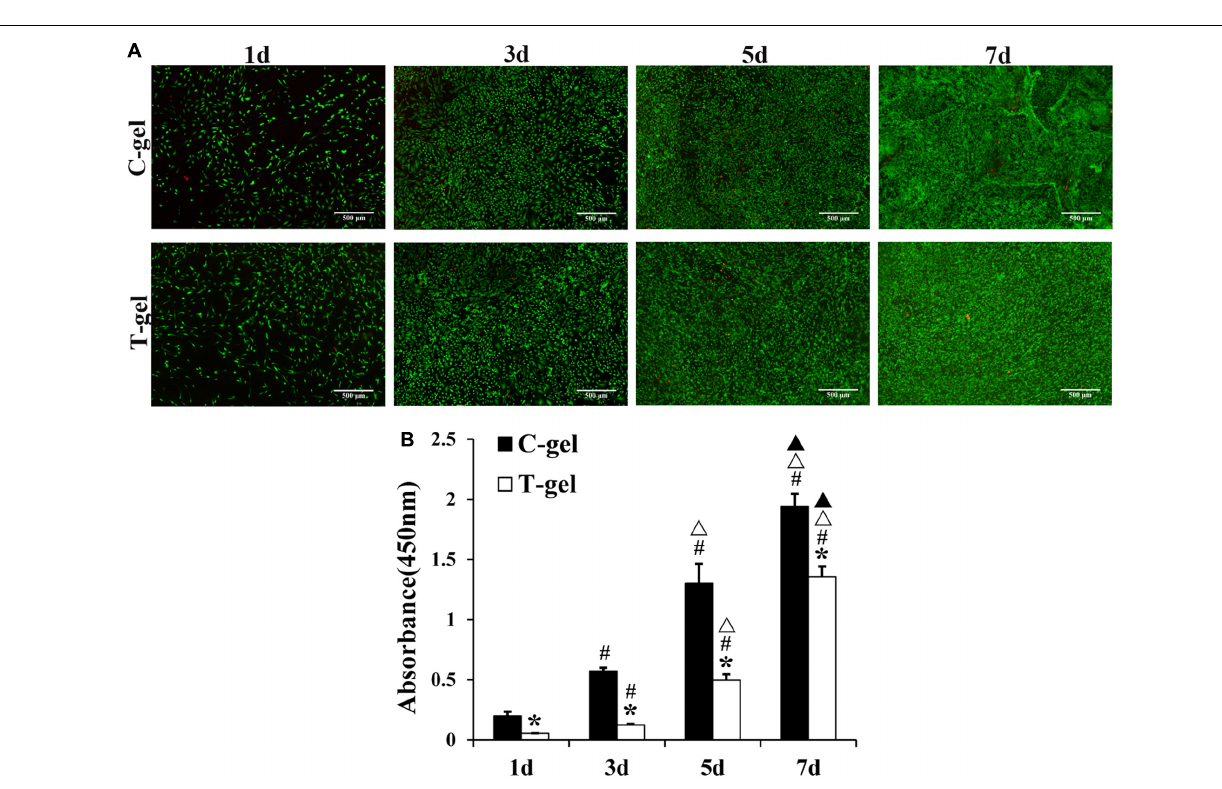
FIGURE 8 | Cell proliferation assays of the C-gel and T-gel. (A) Live/Dead staining of mTDSCs seeded on the C-gel and T-gel at 1, 3, 5, and 7 days by fluorescence microscopy (green, live cells; red, dead cells). Scale bar = 500 µ m. (B) Cell proliferation of mTDSCs cultured on the C-gel and T-gel for 1, 3, 5, and 7 days as determined by the CCK-8 assay. *, signifies a P -value of < 0.05 as compared to the C-gel; #, signifies a P- value of < 0.05 as compared to 1 day for each gel; (cid:77) , signifies a P -value of < 0.05 as compared to 3 days for each gel; (cid:78) , signifies a P -value of < 0.05 as compared to 5 days for each